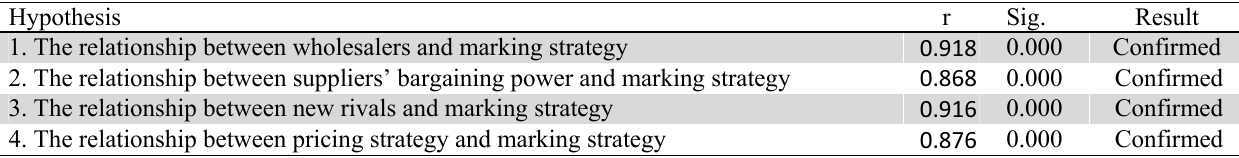
The results of Pearson correlation Hypothesis